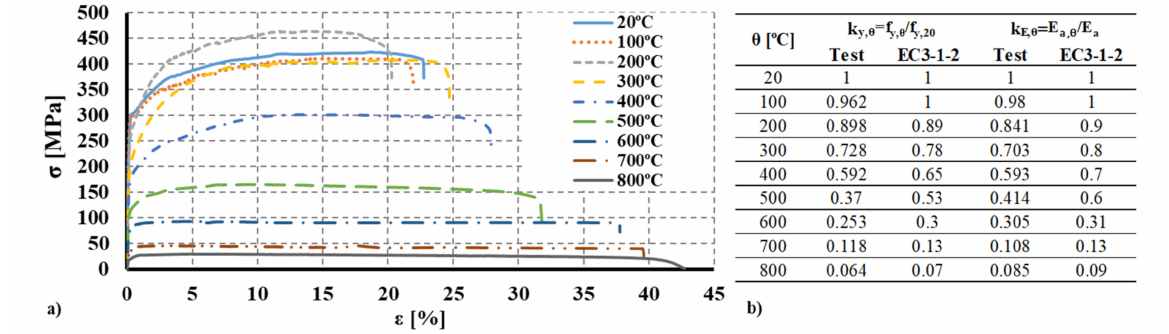
Figure 5. ( a ) Stress-strain curves at elevated temperature [38]. ( b ) Reduction factors for the mechanical properties from the tests and EN